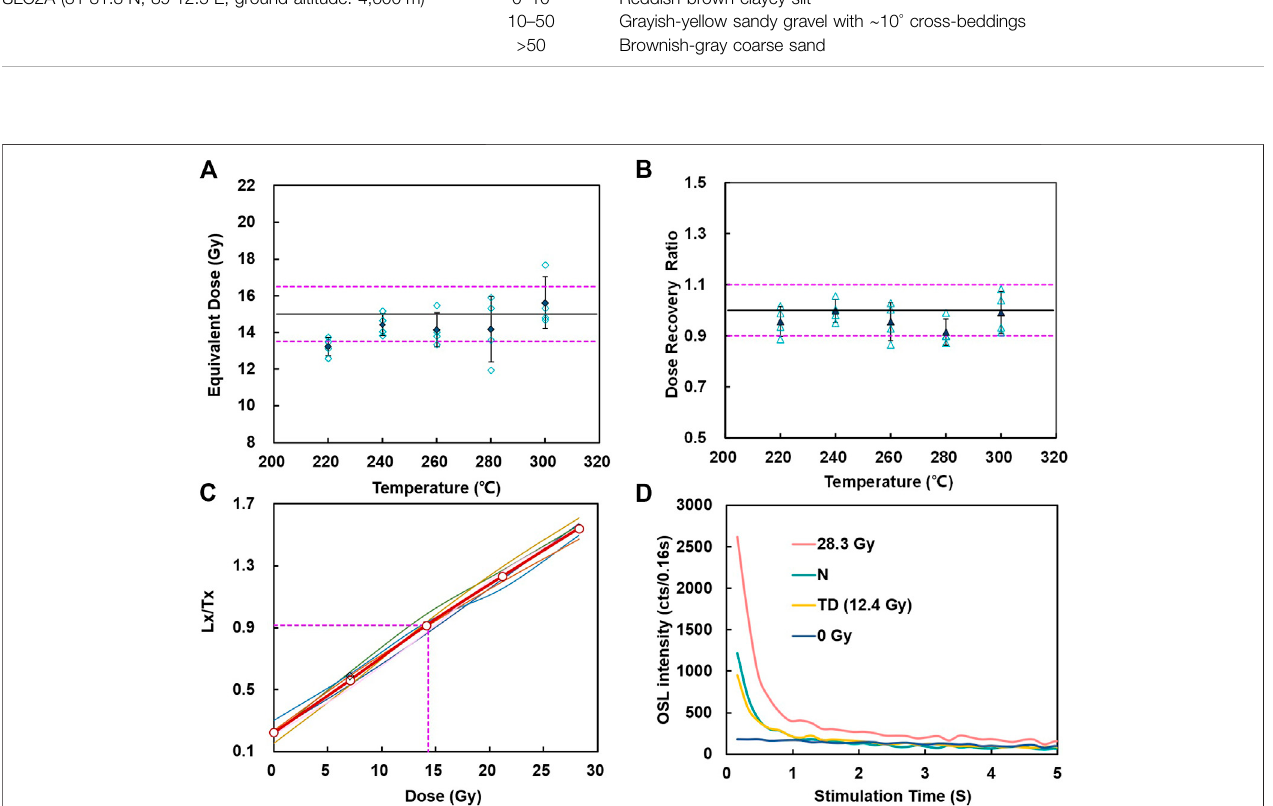
FIGURE 4 | Luminescence characteristics of sample SLC2A-1. (A) Preheat plateau test and (B) dose recovery test. (C) Growth curves of six aliquots and the standardized growth curve (SGC, the red line, and empty circles) averaged from them. Dashed lines indicate the projection of a sensitivity-corrected natural OSL signal onto the SGC to yield a D e value. (D) Decay curves, where N is the natural dose and TD is the test dose.